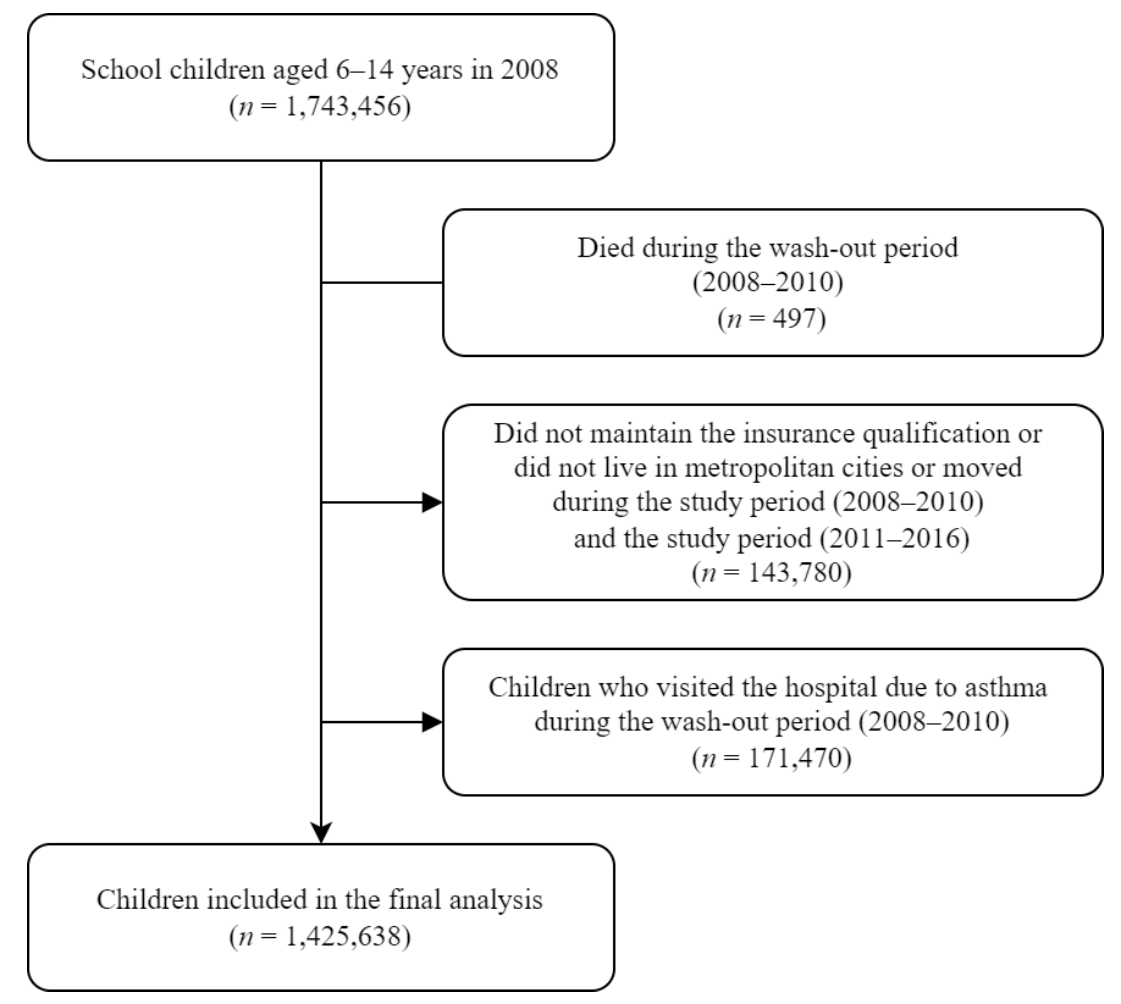
Figure 1. Flow chart of the study population.